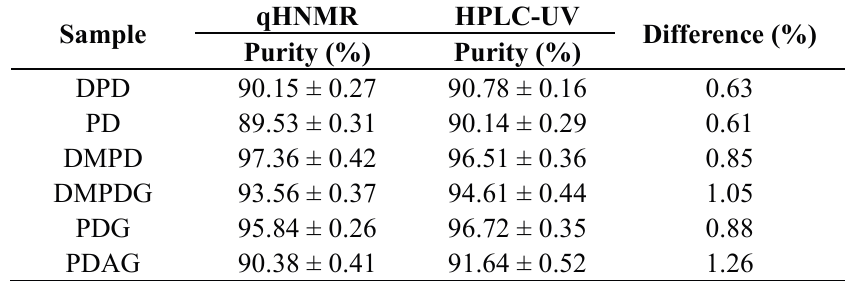
Table 5. The purities of target analytes obtained by qHNMR and